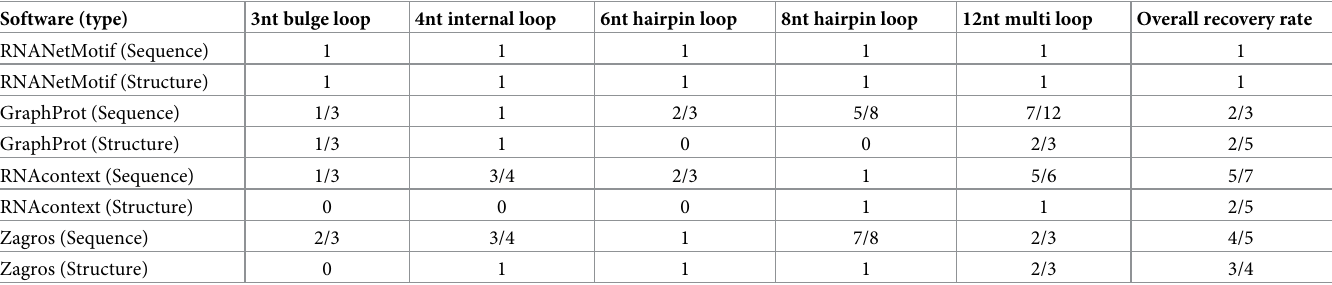
Table 2. Recovery rates of implanted RNA motifs by different methods (Section